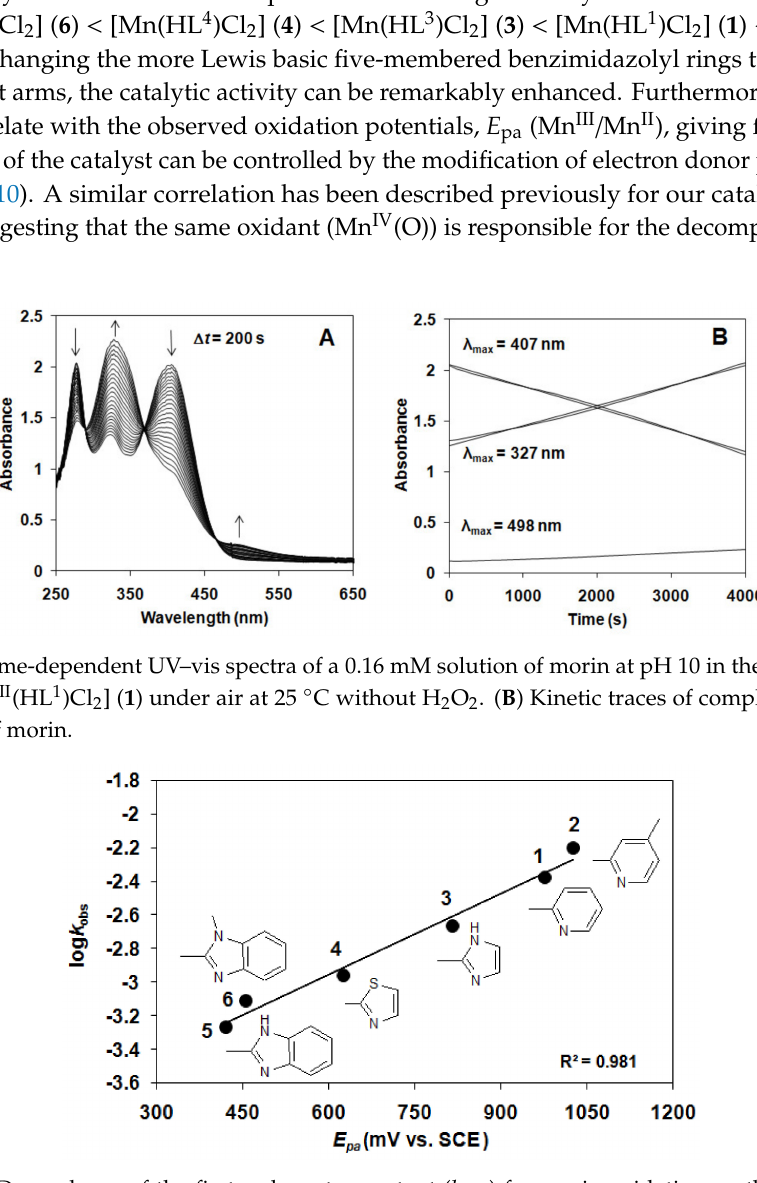
Figure 10. Dependence of the first-order rate constant ( k obs ) for morin oxidation on the oxidation potential ( E pa ) of the [Mn II (HL 1–6 )Cl 2 ] complexes in bicarbonate bu ff er (pH 10). Conditions: [1–6] 0 = 1.6 = 0.16 × 10 − 3 M, [H = 0.010 M at 25 ◦ × 10 − 6 M, [morin] 0 2 O 2 ] 0